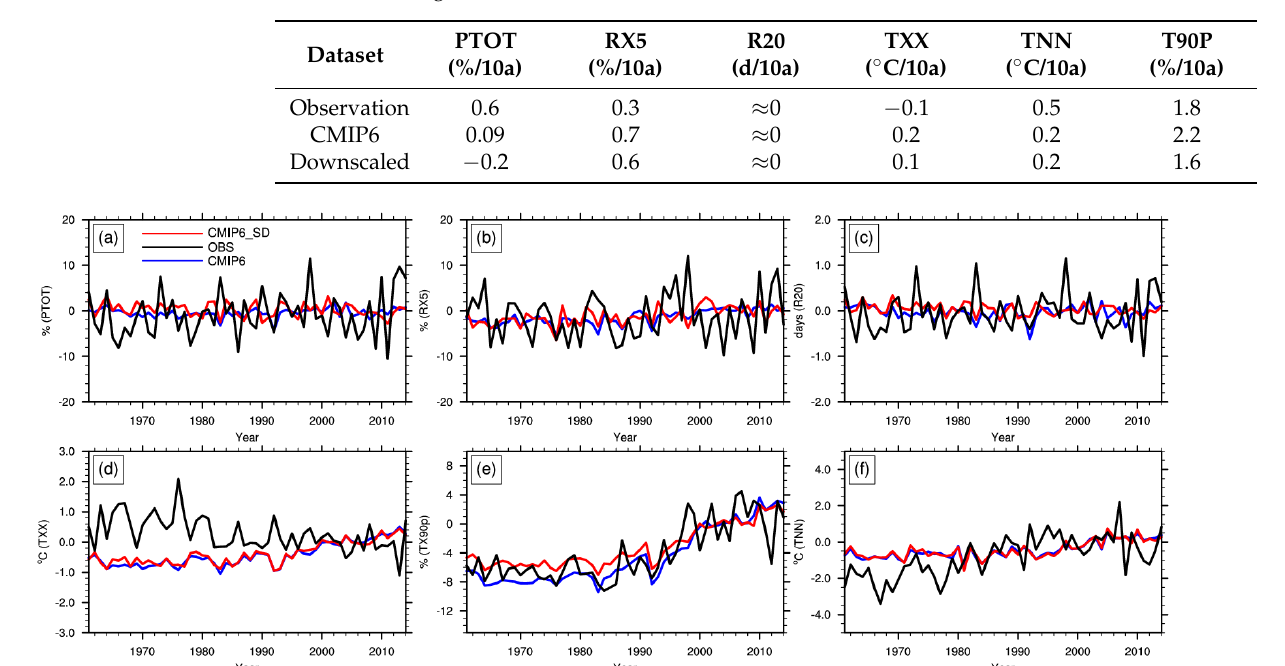
Table 4. The trend coefficients of extreme climate indices over China for observation, MME of CMIP6 and downscaling (/10a.